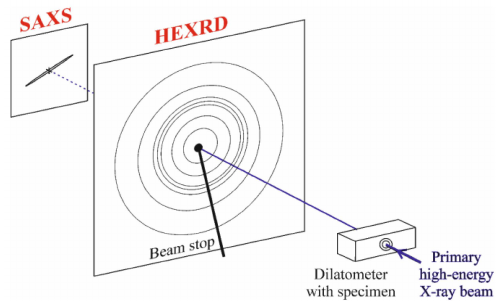
Figure 9. Schematic of the experimental setup for SAXS experiments conducted on C-containing TNM alloy variants [44]. The primary X-ray beam impinges on the specimen within the dilatometer (see Figure 4) and is subsequently scattered/diffracted. Two-dimensional detectors record the SAXS (and if desired, the HEXRD)